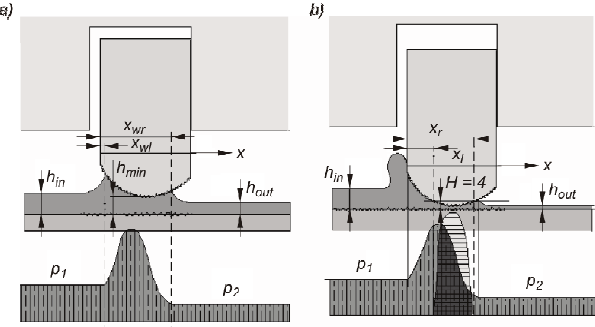
Fig. 2. Scheme of gap between the ring face and cylinder liner in the case of: a) fluid and b) mixed